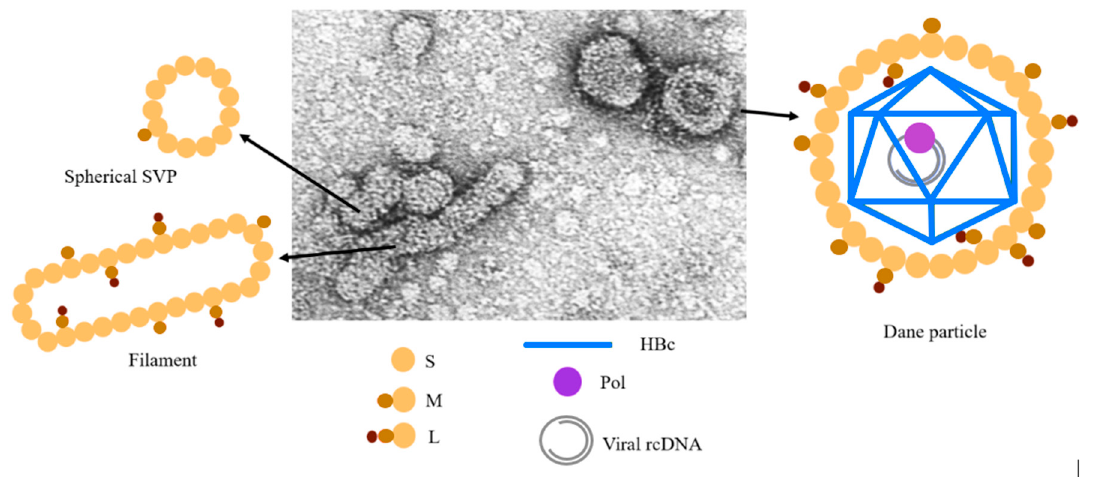
Figure 1. Schematic representation of HBV virions. Spherical and filamentous particles (SVPs) correspond to small (20 nm) entities only composed of the envelope proteins [13]. They are empty, not infectious and represent the most abundant particles found in the supernatant milieu of infected cells or in the sera of chronically infected subjects. Infectious particles (Dane particles) are larger, 42 nm in diameter, and are formed by an icosahedral capsid embedded in a lipid membrane containing the S, L and M surface proteins [10]. The internal nucleocapsid contains the circular partially double-stranded genomic DNA (rcDNA), about 3.2 kb in length, which is covalently linked to the viral reverse transcriptase. More recently, a large quantity of empty virions corresponding to enveloped capsid without rcDNA were found in cell supernatant or patient serum [11].